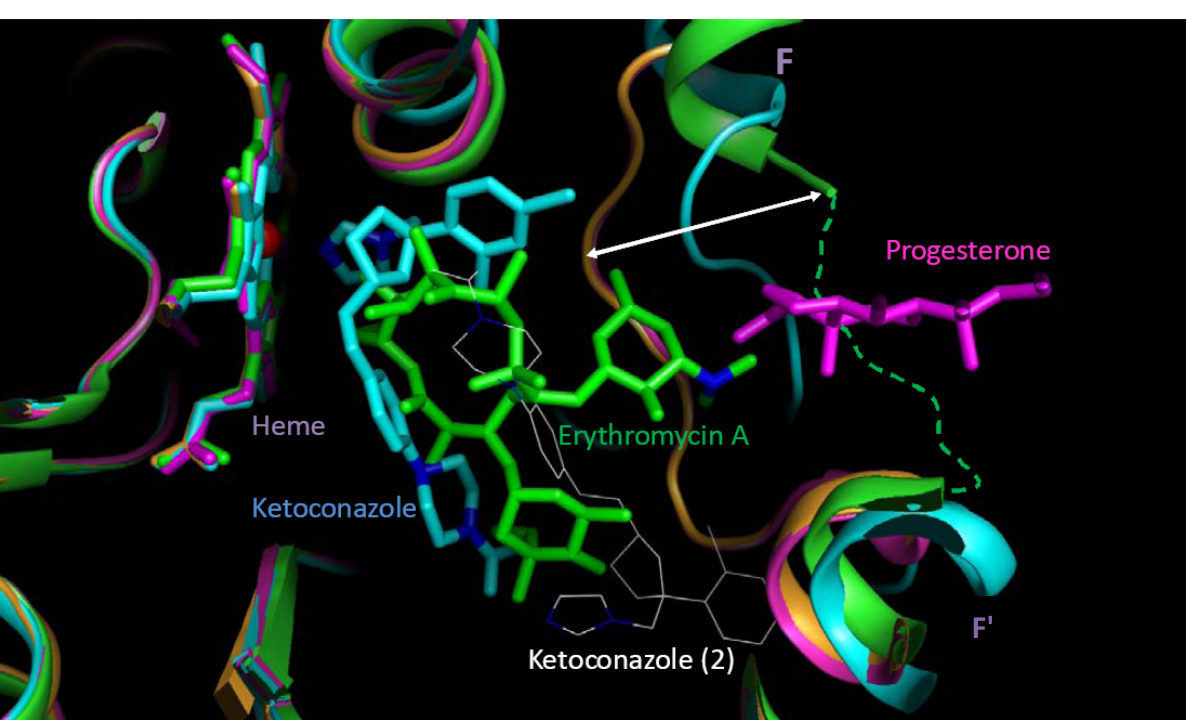
Figure 7. An active site view of superimposed crystal structures of the human CYP3A4 isozyme. 1TQN (no bound molecule) is shown in orange, 1W0F (with bound progesterone) in magenta, 2J0D (with bound erythromycin A) in green, and 2V0M (with bound ketoconazole) in cyan. The catalytic iron atom of the heme moiety is shown as a red van der Waals sphere. The active site volume is confined by the heme on the left and a flexible F–F ′ loop that flanks the active site on the right. Nitrogenated sites-of-metabolism (SOM) on the ligands are shown in blue. As evidenced by the disposition of ketoconazole SOM in respect to the heme, ketoconazole is regioselectively bound at the substrate site next to the catalytic heme group (on the left), while erythromycin, although at the same site, is bound in a non-productive (inhibiting) orientation. Progesterone is bound at an allosteric binding pocket at the entrance of the active site of 1W0F (on the right). The active site of 1W0F is ligand-free and, thus, similar to ligand-free 1TQN as evidenced by overlapping positions of the flanking loop (left end of the white arrow). Upon substrate binding, the loop expands first to accommodate two ketoconazole molecules (2V0M, middle of the white arrow) and then further, to accommodate an even larger erythromycin A (2J0D, right end of the white arrow). Thus, the white arrow points at the most contracted and the most expanded conformations of the flanking F–F ′ loop. The active site expands from the left to the right of the arrow to fit the size of substrate, and when the loop is at the right-most position (2J0D), volume of the active site is increased by more than 80% [98]. The green dashed trace denotes five disordered residues of the flanking loop, for which the coordinates have not been resolved in the 2J0D structure because of poor electron density in that region. Note the second ketoconazole molecule at the bottom (thin white); it is bound to the same crystal structure 2V0M but in a non-productive pose at an auxiliary pocket within the active site of CYP3A4, which expands to accommodate both